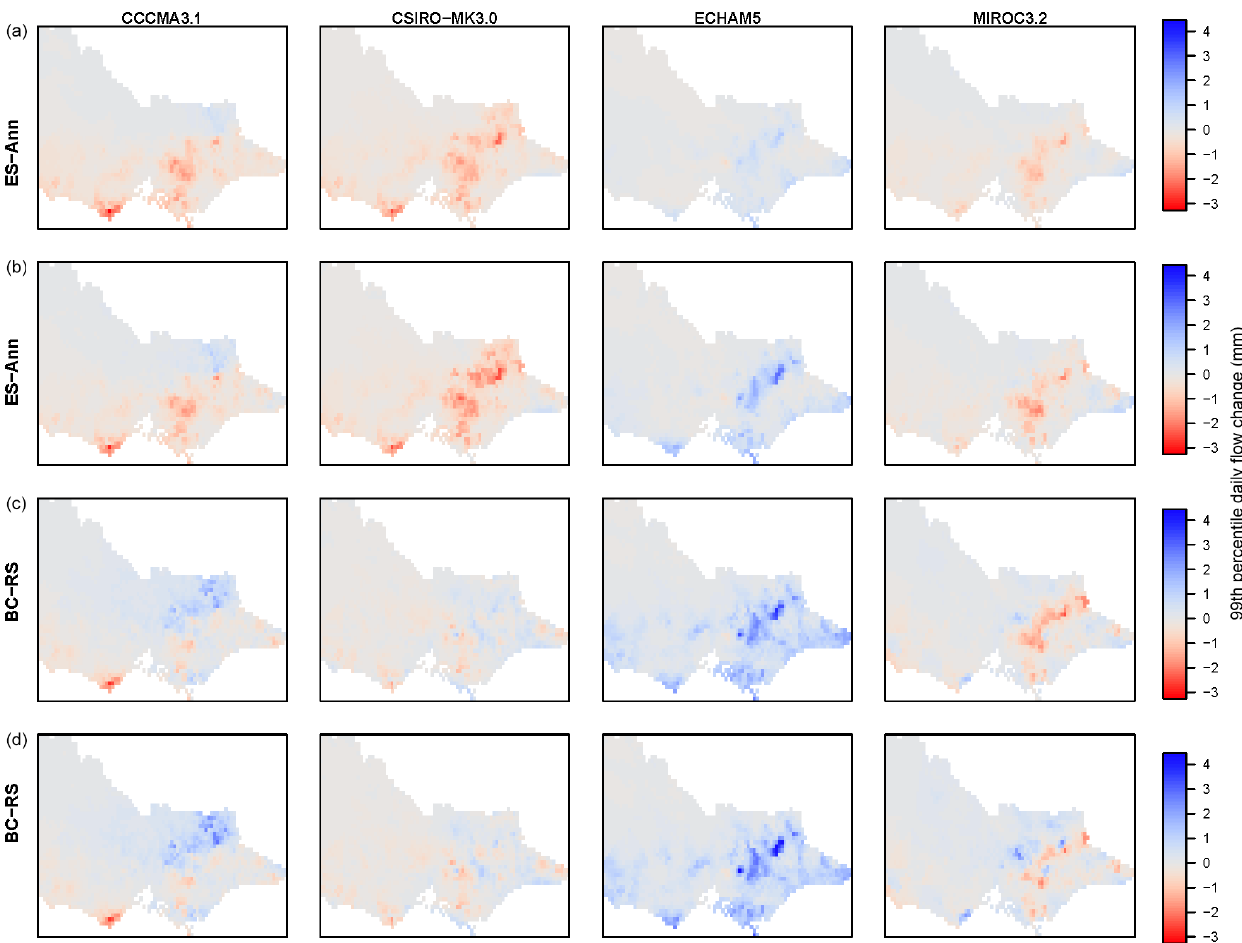
Figure 6. Change in 99th-percentile daily flow (mm, future minus historical) for (a) ES-ann, (b) ES-seaann, (c) BC RS and (d) BC. Columns (left to right) show CCCMA3.1, CSIRO-MK3.0, ECHAM5 and